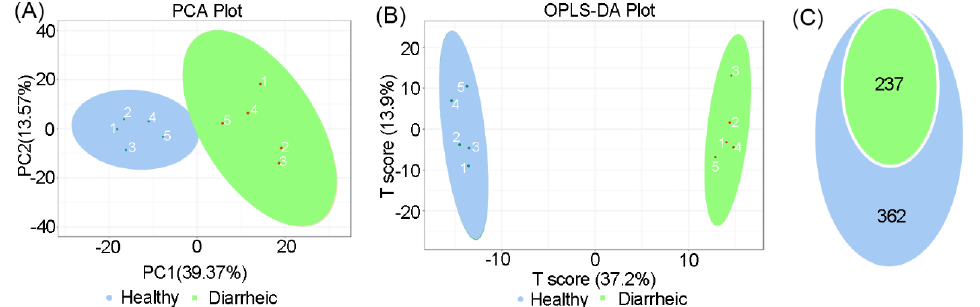
Figure 3. Total metabolite comparisons between groups. PCA score plots ( A ) and OPLS-DA score plots ( B ) based on fecal metabolomics in groups. ( C ) Differential metabolites were identified based on OPLS-DA analysis using p < 0.05 and VIP ≥ 1 as filters between groups. Blue = p < 0.05; green = p < 0.05 and VIP ≥ 1 ( n = 5 animals/group).